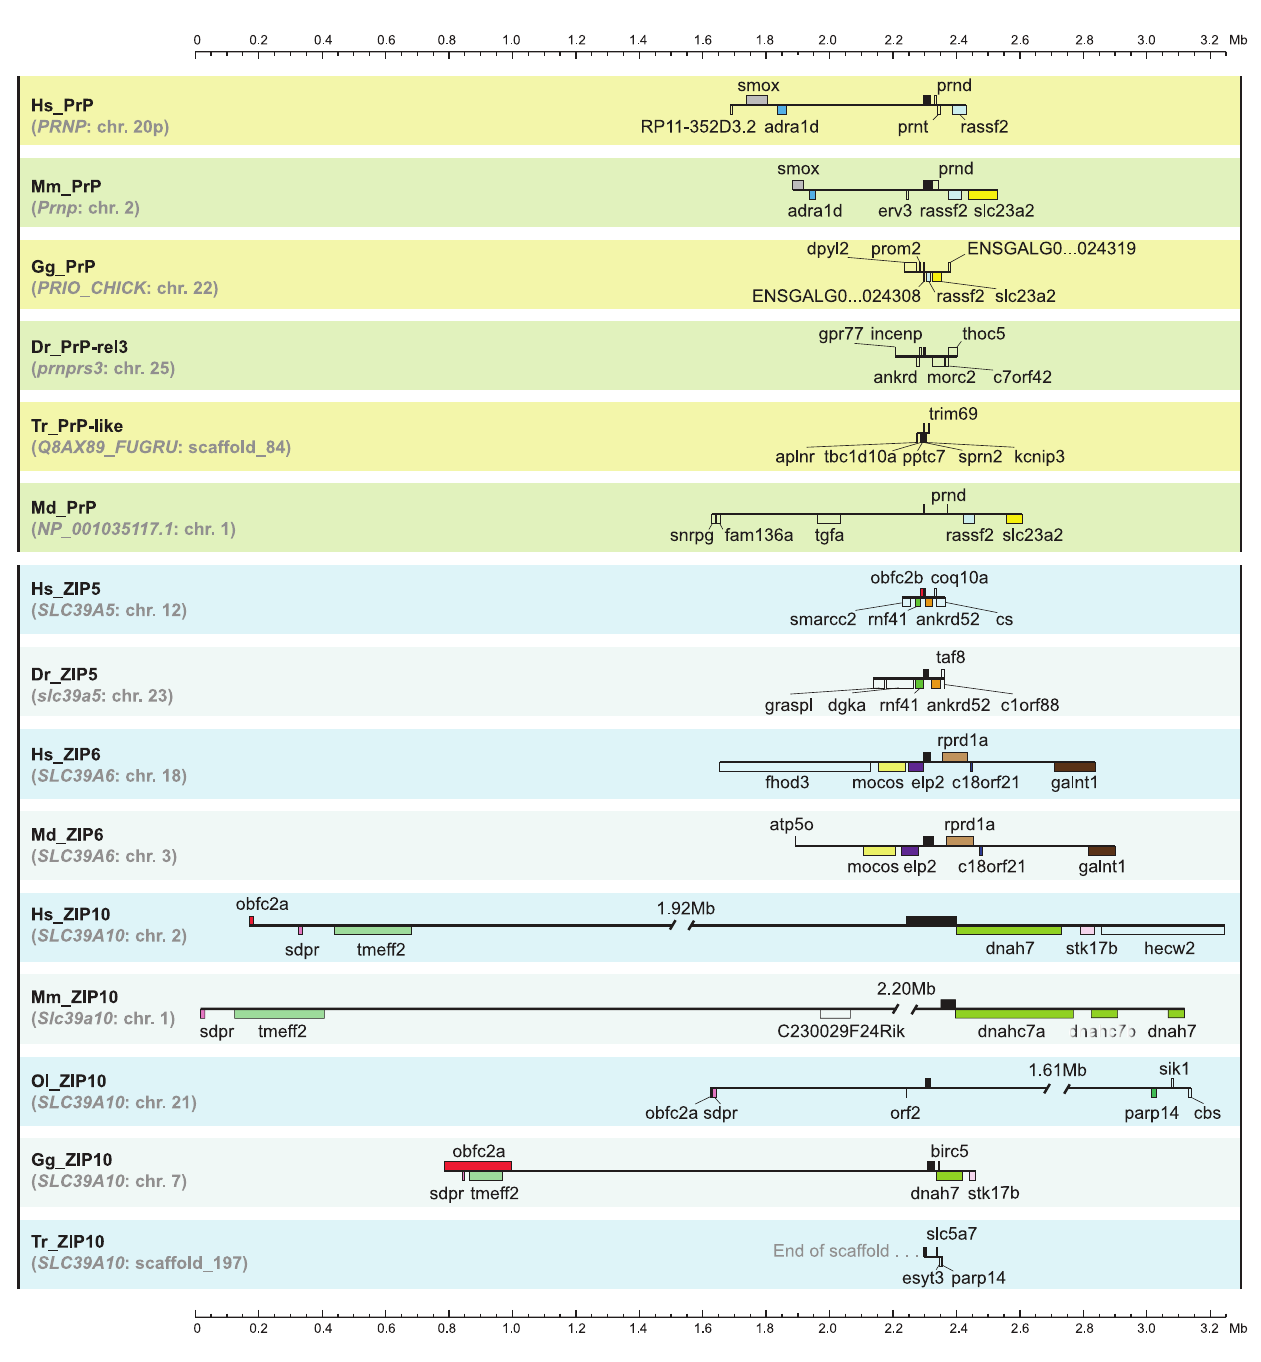
Figure 4. Lack of shared genes in proximity of PrP and ZIP genes. The synteny analysis was restricted to three adjacent genes on either side of the relevant PrP and ZIP genes. Synteny was determined to be restricted to ortholog sequences, with paralogs of the gene obfc2 observed adjacent to both ZIP5 and ZIP10 genes serving as notable exceptions. Black boxes depict the genes of interests (PrP/ZIP), and colored boxes represent proximal genes. Please note that Tr_ZIP10 maps to the 5 9 boundary of a genomic contig for which the adjacent genomic segment is not annotated. Black solid lines indicate interspersed non-coding regions. Mb, megabase pairs.